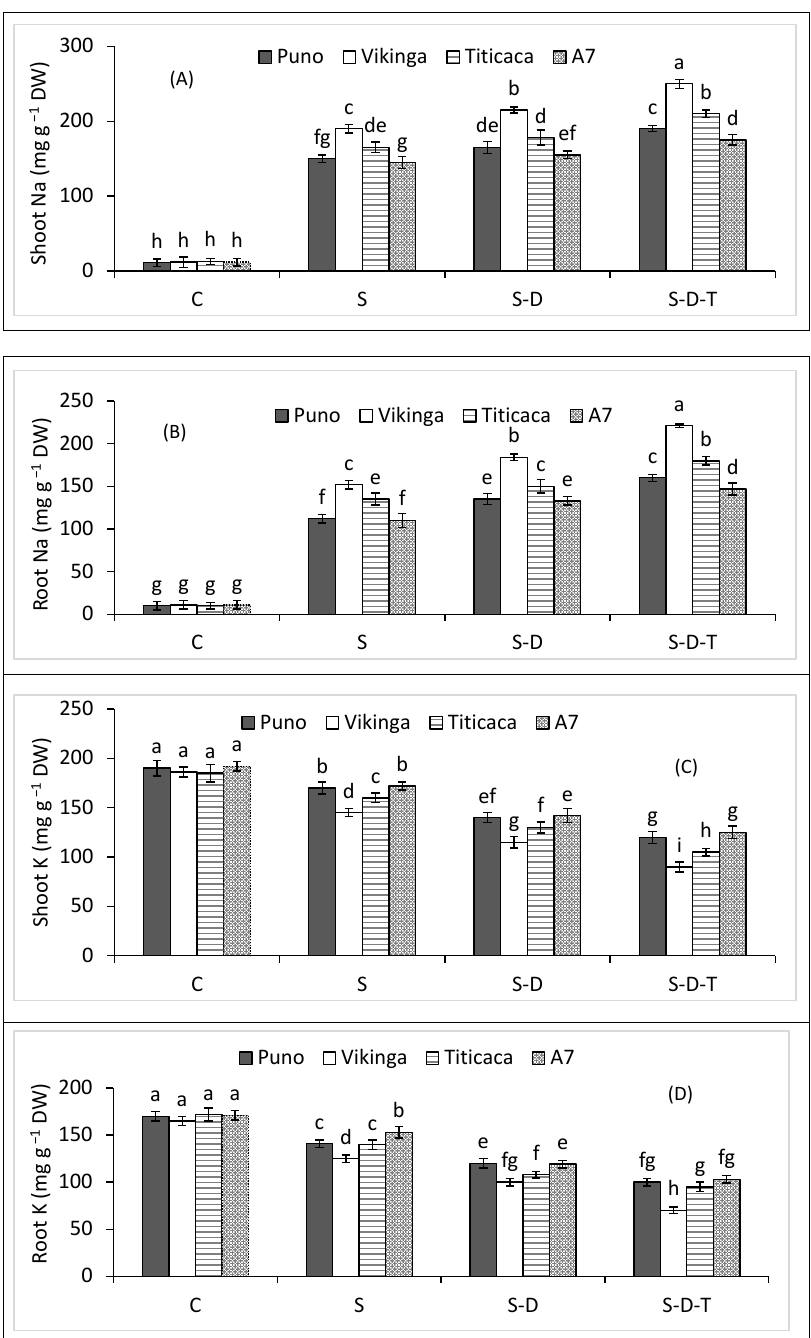
Figure 3. ( A ) Shoot Na, ( B ) root Na, ( C ) shoot K, and ( D ) root K of quinoa genotypes under control (C), salinity (S), drought (D), and high-temperature (T) stress. S-D, combined salinity and drought treatment; S-D-T, combined salinity, drought, and high-temperature treatment. The values for each parameter are the means of three replicates ± SE. At the 5% probability level, bars with different letters indicate significant differences.